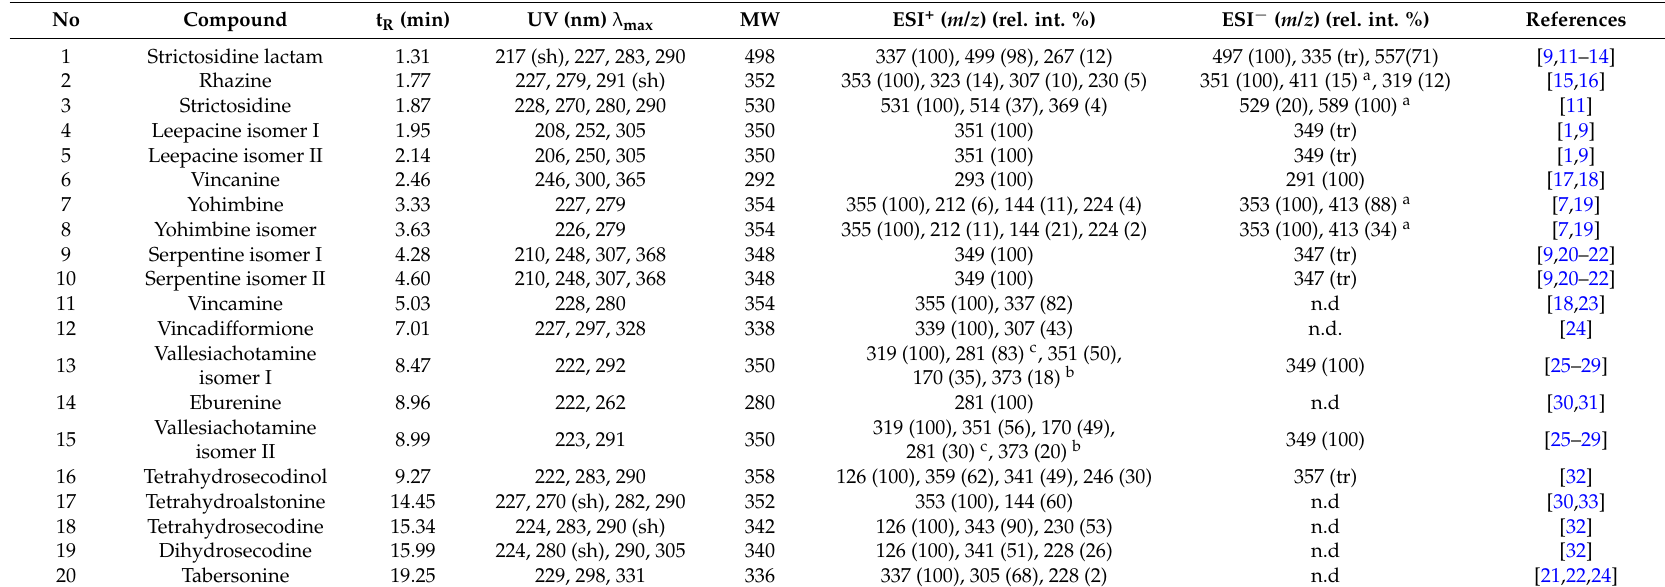
Table 2. Identification of indole alkaloids of Rhazya stricta hairy roots by